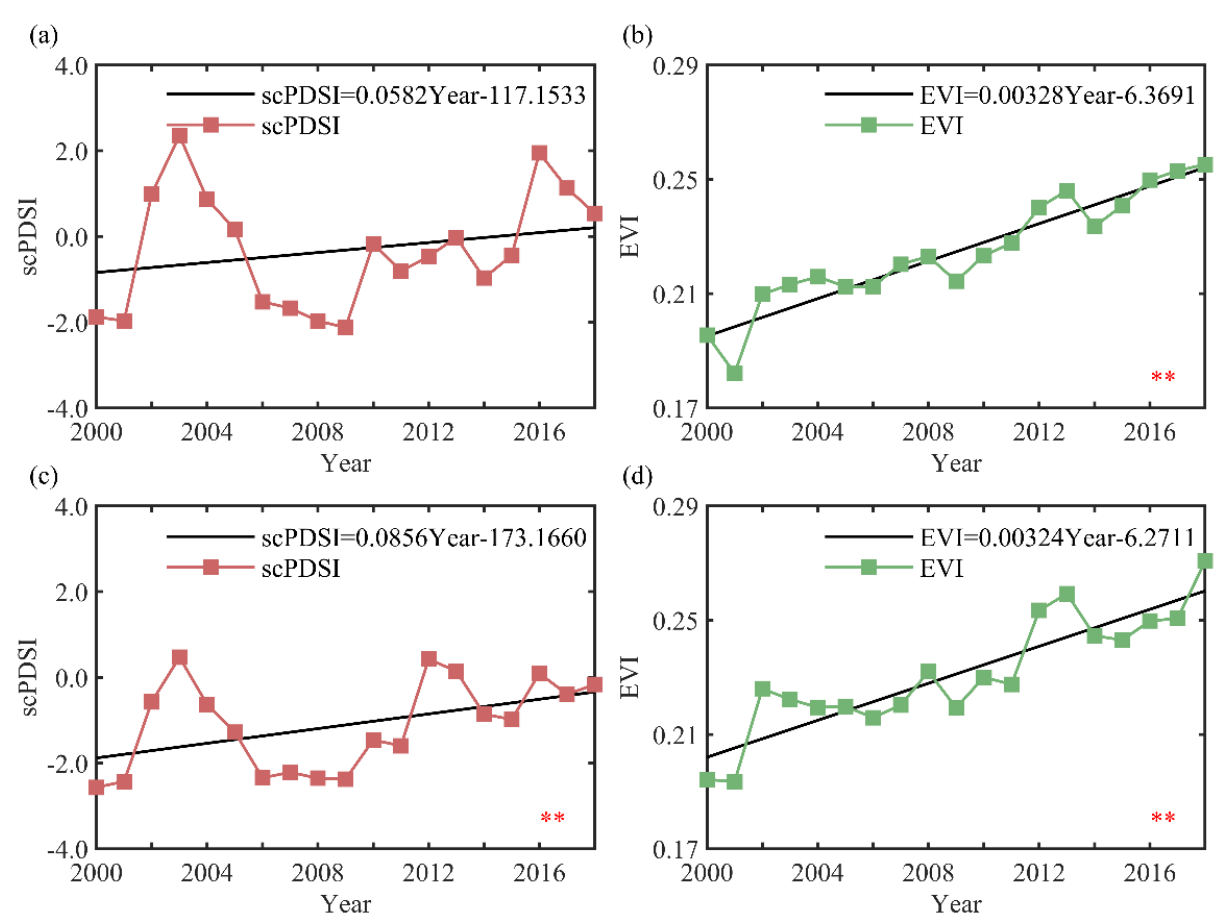
Figure 4. Trends in drought and EVI during the growing season in farmland ecosystems in the DNC from 2000 to 2018. ( a ) scPDSI in arid drylands, ( b ) EVI in arid drylands, ( c ) scPDSI in semi-arid drylands, and ( d ) EVI in semi-arid drylands. ** means significance of trends were assessed at p < 0.05. (The lines marked with square blocks represent the true values; black solid lines represent the linear fitting values.).